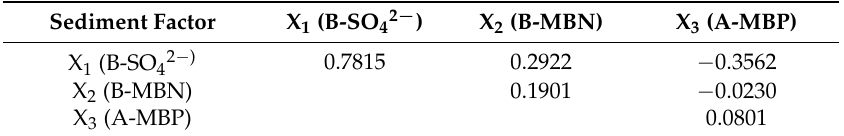
Table 8. The determination coefficient of each factor affects the sediment phosphorus release